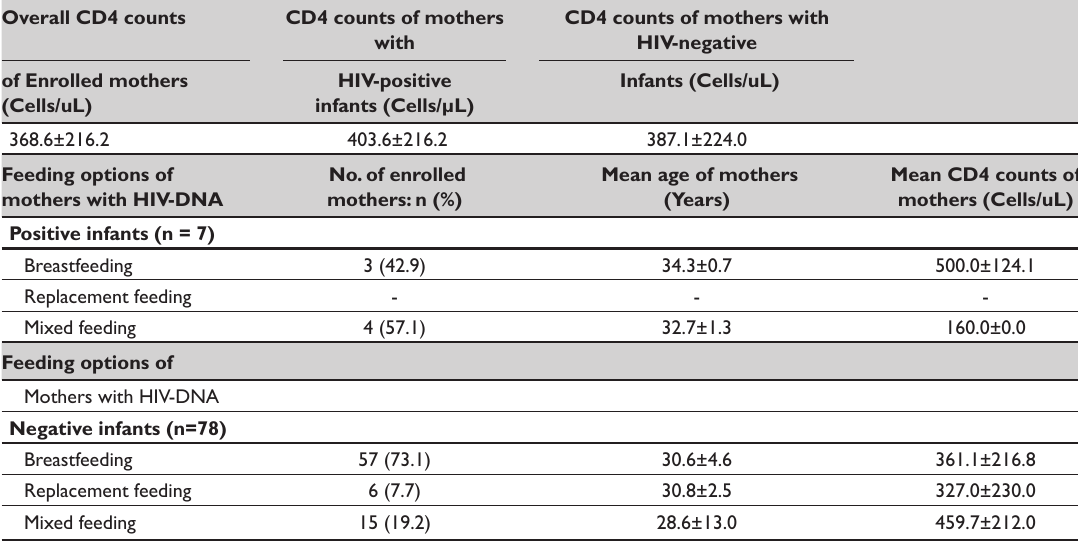
Table 2: Mean CD4 counts of enrolled mothers based on infants HIV‑status and feeding